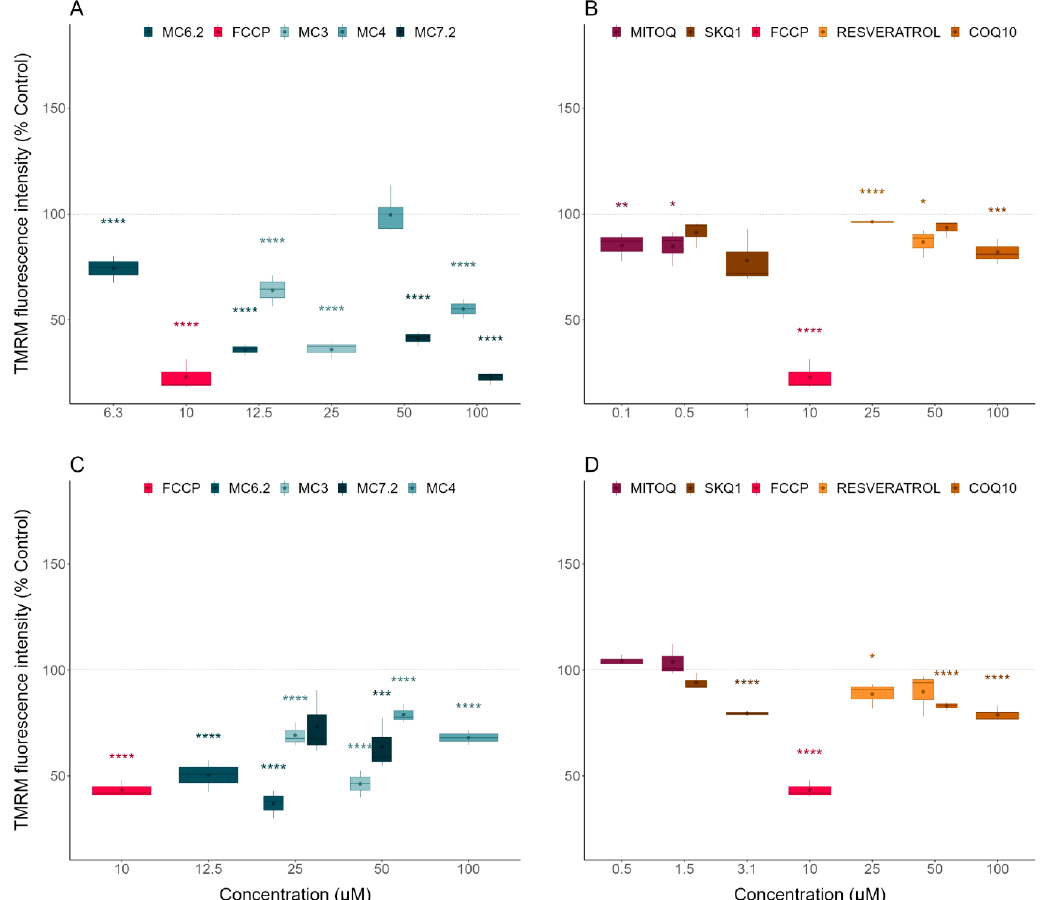
Figure 5. Effect of MitoCINs, quinone-based mitochondria-targeted and non-targeted antioxidants on TMRM intensity fluorescence. Human Caucasian hepatocyte carcinoma (HepG2, ( A , B )) and differentiated human neuroblastoma (SH-SY5Y, ( C , D )) were treated with increasing concentrations of the different molecules for a period of 48 h and mitochondrial membrane potential was indirectly evaluated using TMRM fluorescence intensity. Data are the mean ± SE of three independent experiments and the results are expressed as percentage of the control (control = 100%). Statistically significant differences between control (CTL) and treated groups were evaluated using a t -test. **** p < 0.0001, *** p < 0.001, ** p < 0.01 and * p < 0.05 compared to the respective control (CTL).